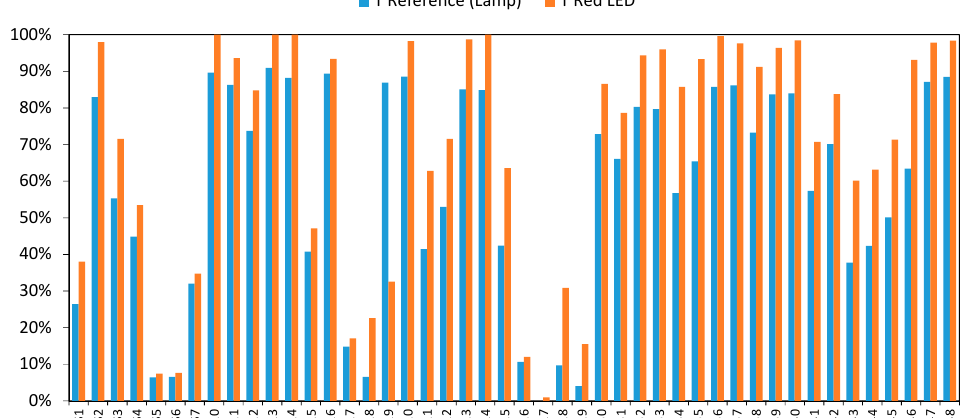
Sensors 2020 , 20 , x FOR PEER REVIEW Figure 6. Comparative transmittance value by the red LED and incandescent lamp at 625 nm.